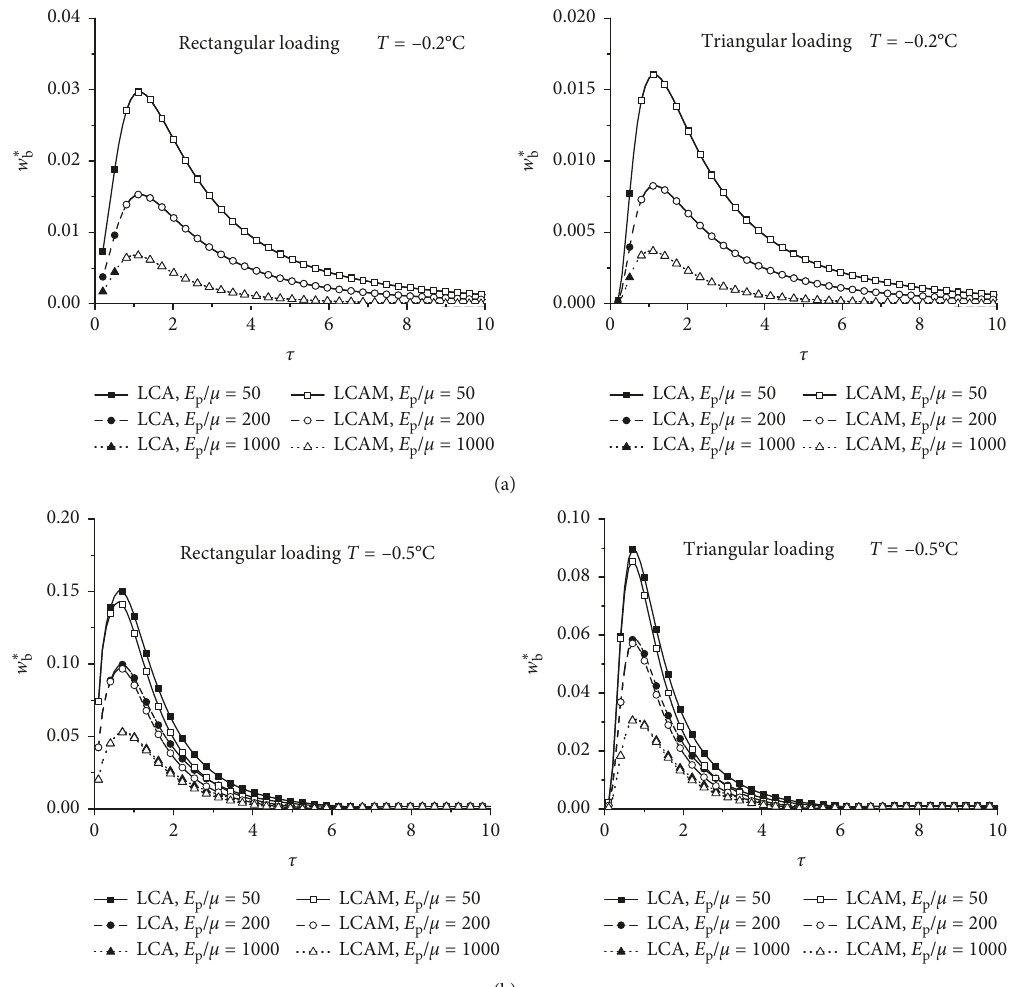
Figure 5: Comparisons of dynamic response of pile with LCAM and LCA models. (a) T